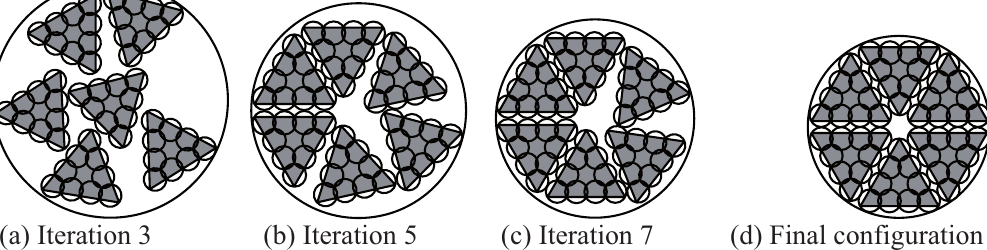
Fig. 9. Design iteration and the packing result.